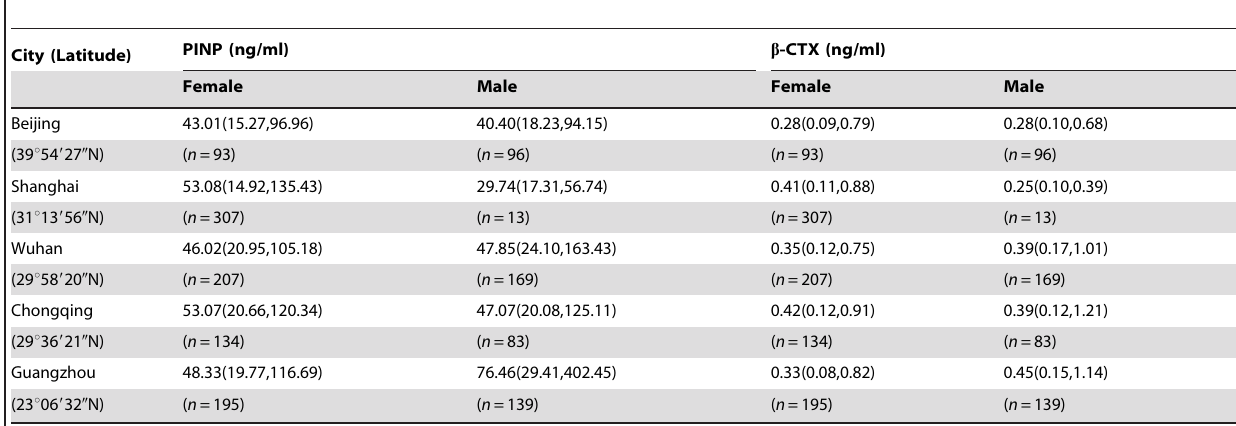
Table 2. PINP and b -CTX levels in male and female subjects by sites of recruitment